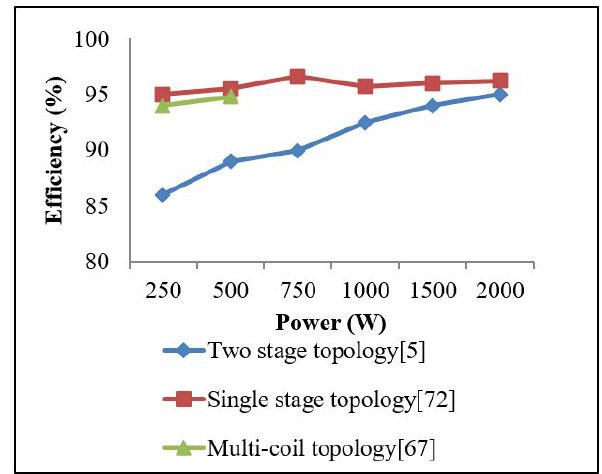
Figure 8. Comparison of efficiency of various IH topologies.